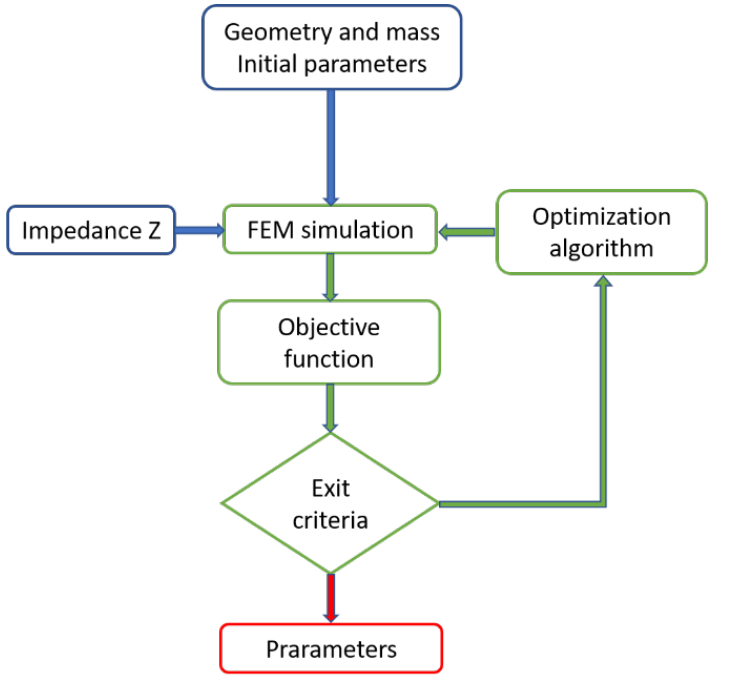
Figure 1. Flow chart of the forward optimization approach using Finite Element Method (FEM). Blue indicates the input data, green the calculus performed at each step in the loop and red the results.